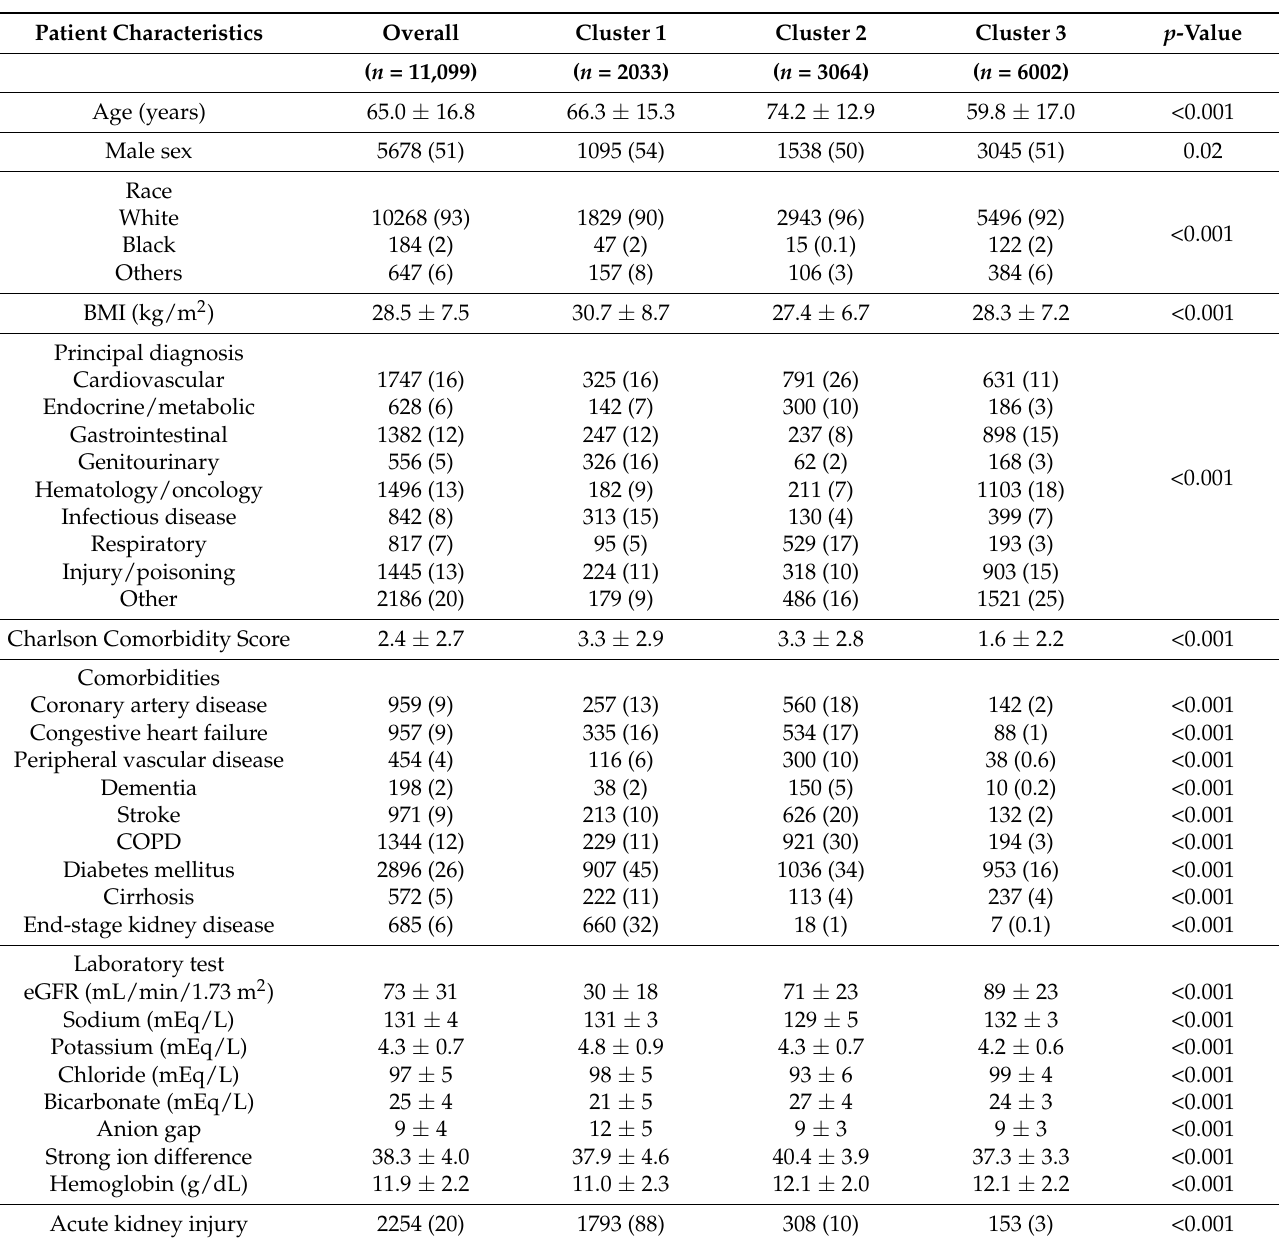
Table 1. Clinical